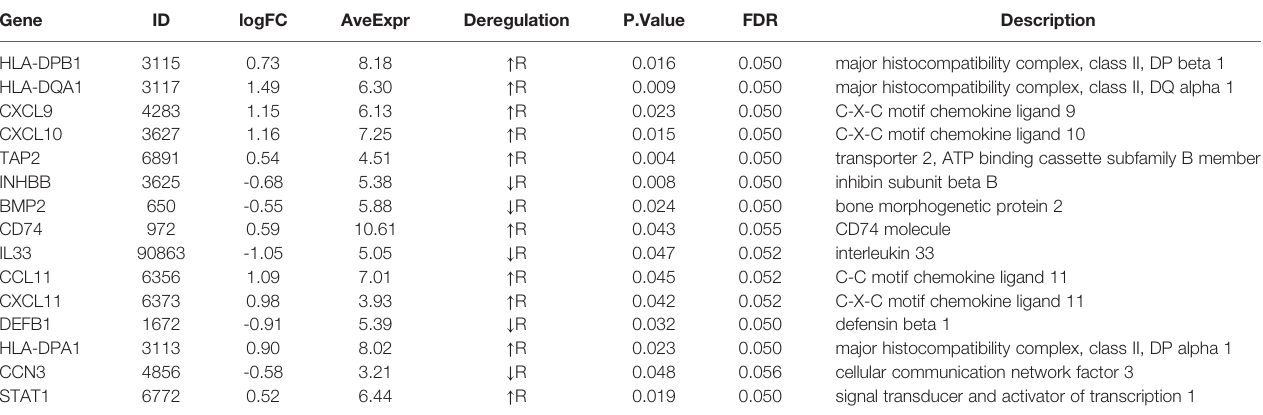
TABLE 2 | The 15 differentially expressed immune-related